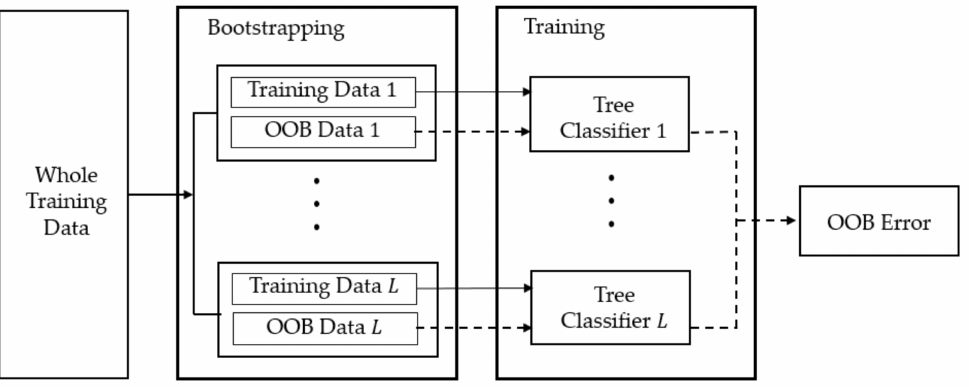
Figure 4. Schematic flow diagram of generating a random forest